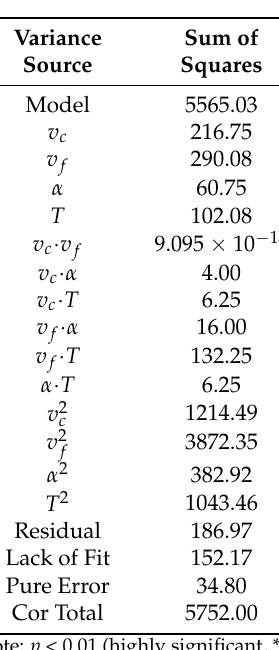
Table 5. Analysis of variance for sawing surface quality score